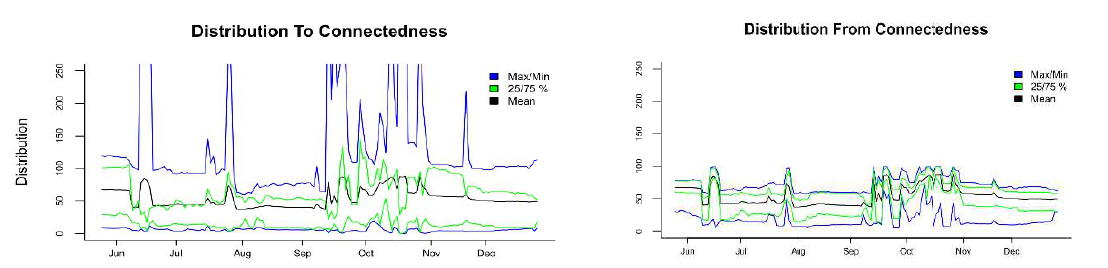
Fig. 4. Distribu nnectedness du